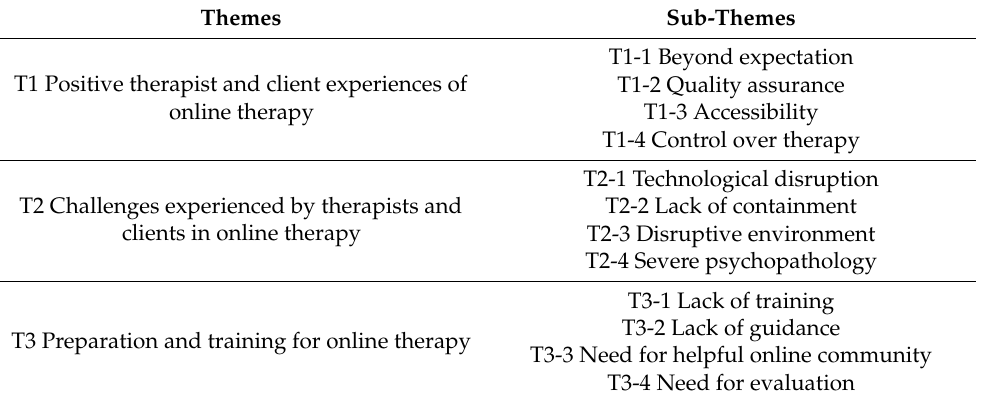
Table 3. Themes and